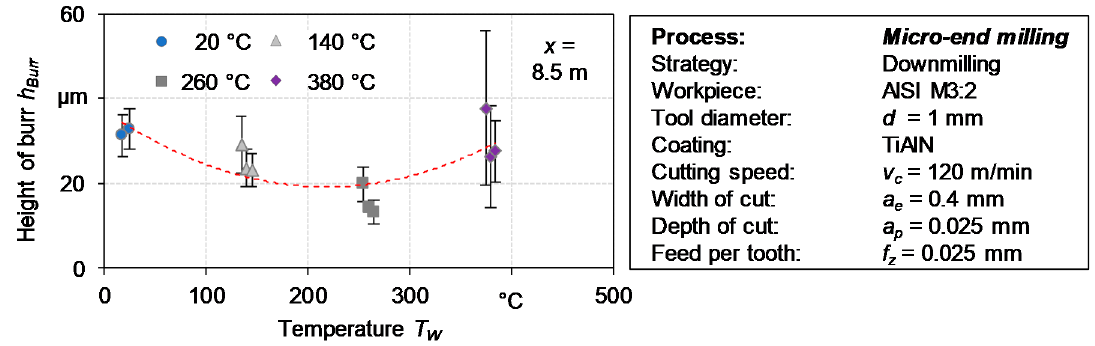
Figure 6. Top burr height h Burr by thermally assisted micromilling a HSS AISI M3:2.